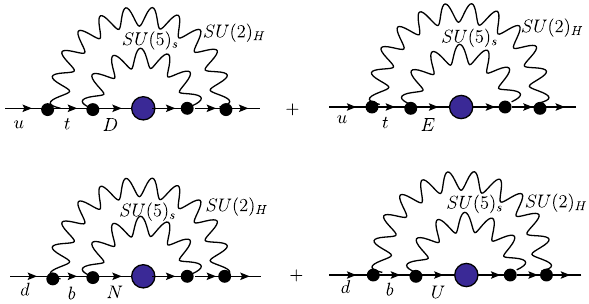
Fig. 4 Horizontal symmetry contribution to the b quark mass